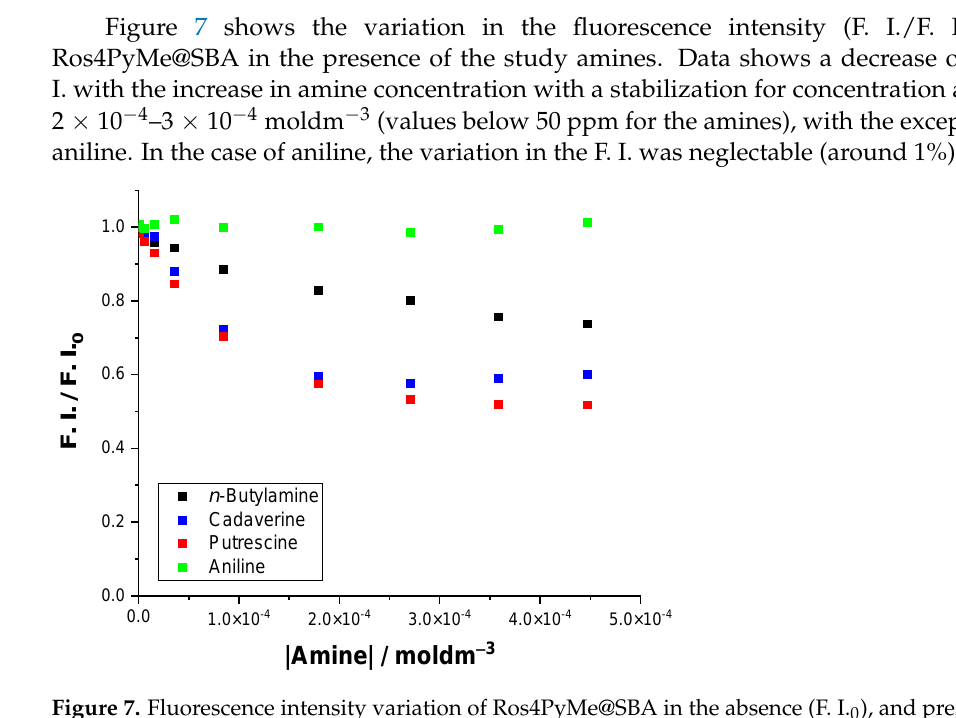
Figure 7. Fluorescence intensity variation of Ros4PyMe@SBA in the absence (F. I. 0 ), and presence of increasing amounts (up to 4.47 × 10 − 4 moldm − 3 ) of the selected amines ( n -butylamine, cadaverine, putrescine and aniline) in water at 25 °C.